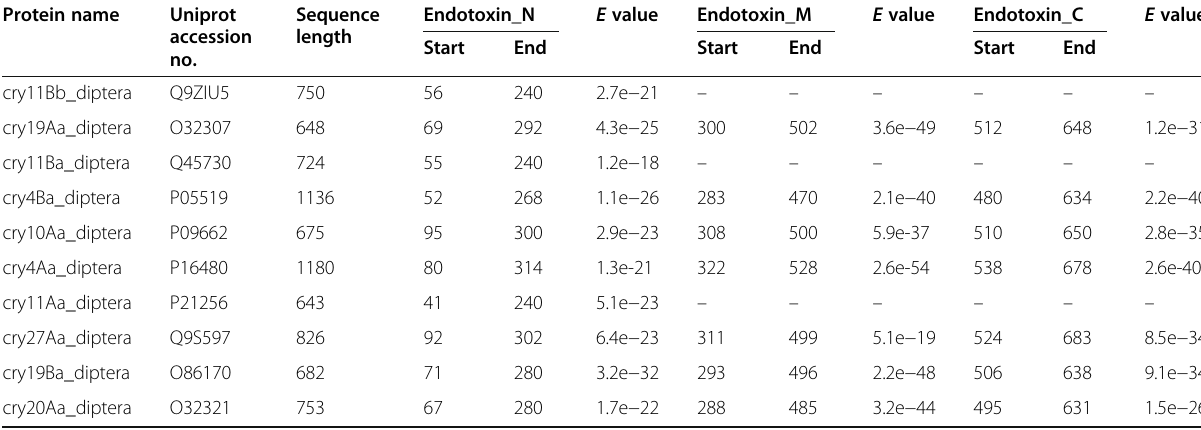
Table 5 List of cry protein domains having toxicity for Diptera insect